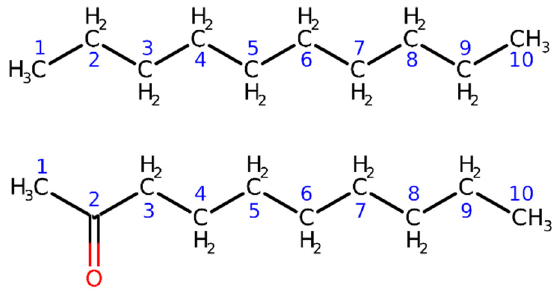
Figure 1. Schematic representation of the model systems considered in the first validation tests on the IMOM/ELMO method for the determination of core-ionized states: decane and 2-decanone (top and bottom panels, respectively). The numbers indicate the labels of the carbon atoms gradually included in the quantum mechanical region of the IMOM/ELMO computations.